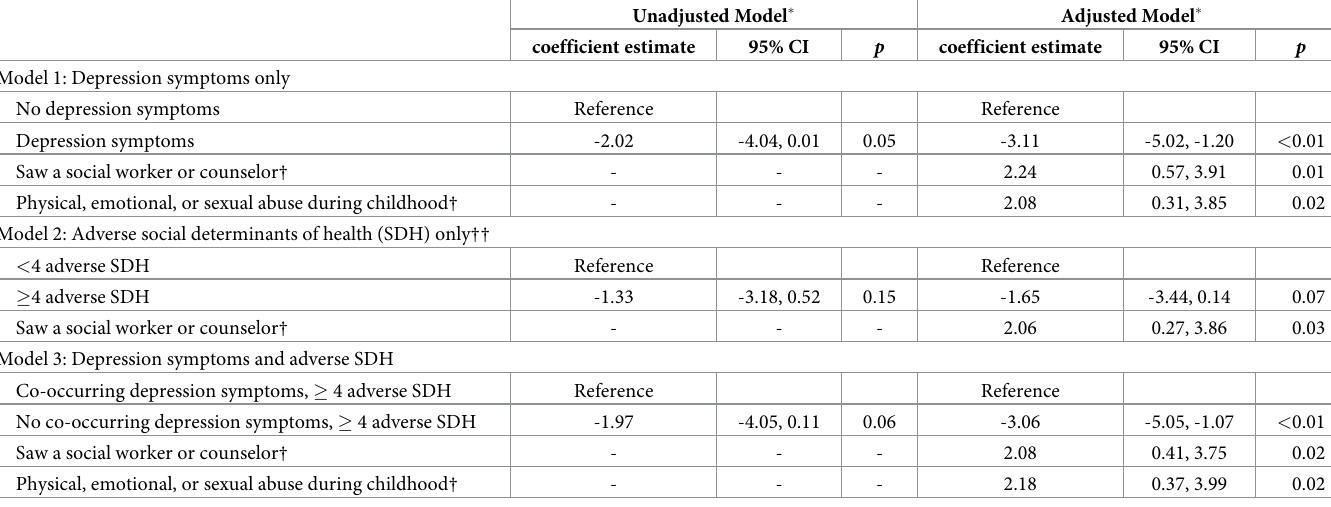
Table 3. Regression models examining associations between gestational age and prenatal depression symptoms, adverse social determinants, and co-occurring depression symptoms and social